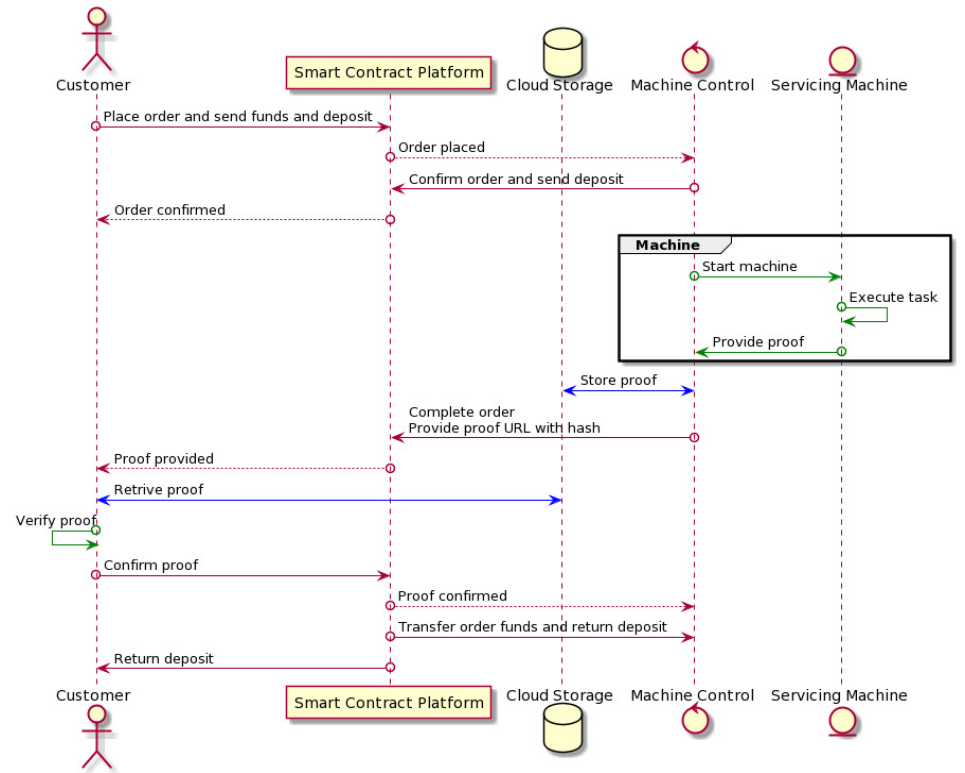
Figure 2. Order processing sequence